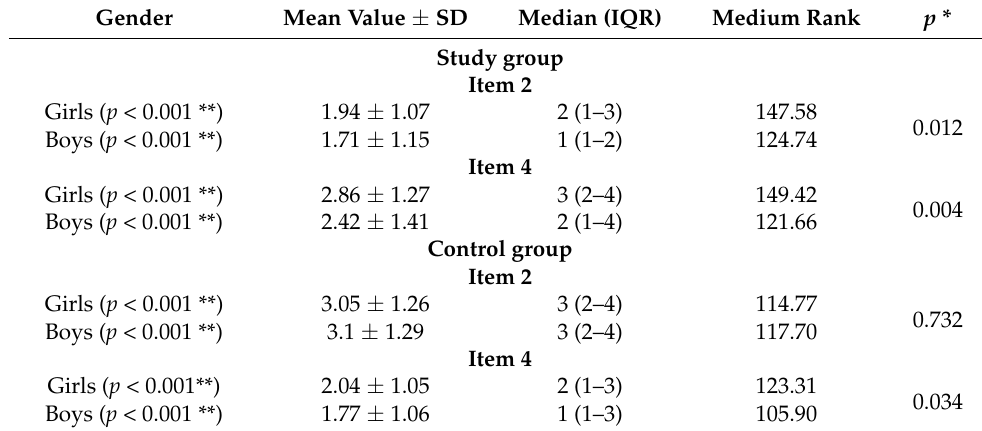
Table 7. Comparison of answers provided for Items 2 and 4 in relation to gender. Gender Mean Value ± SD Median (IQR) Medium Rank p * Study group Item 2 Girls ( p < 0.001